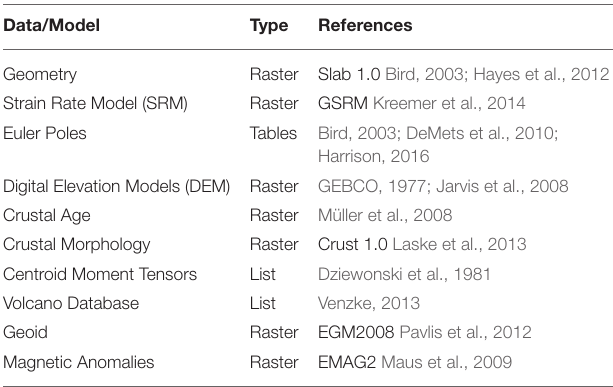
TABLE 1 | A summarizing overview of all data sources considered for the assessment of subduction zone